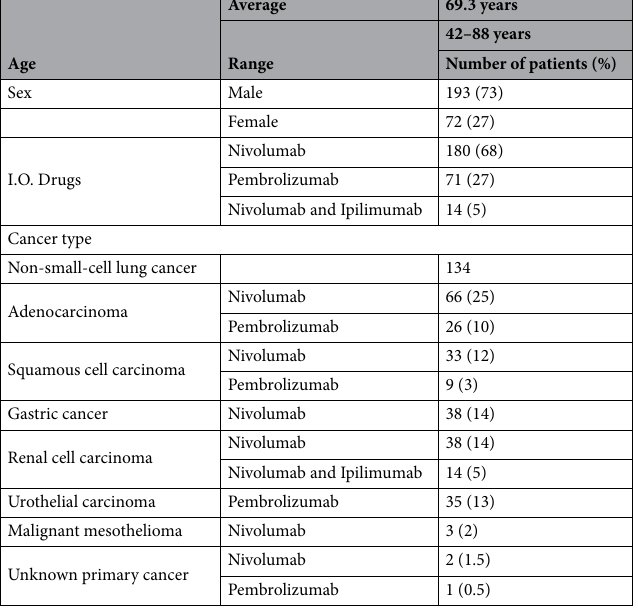
Table 1. Patient characteristics (n =